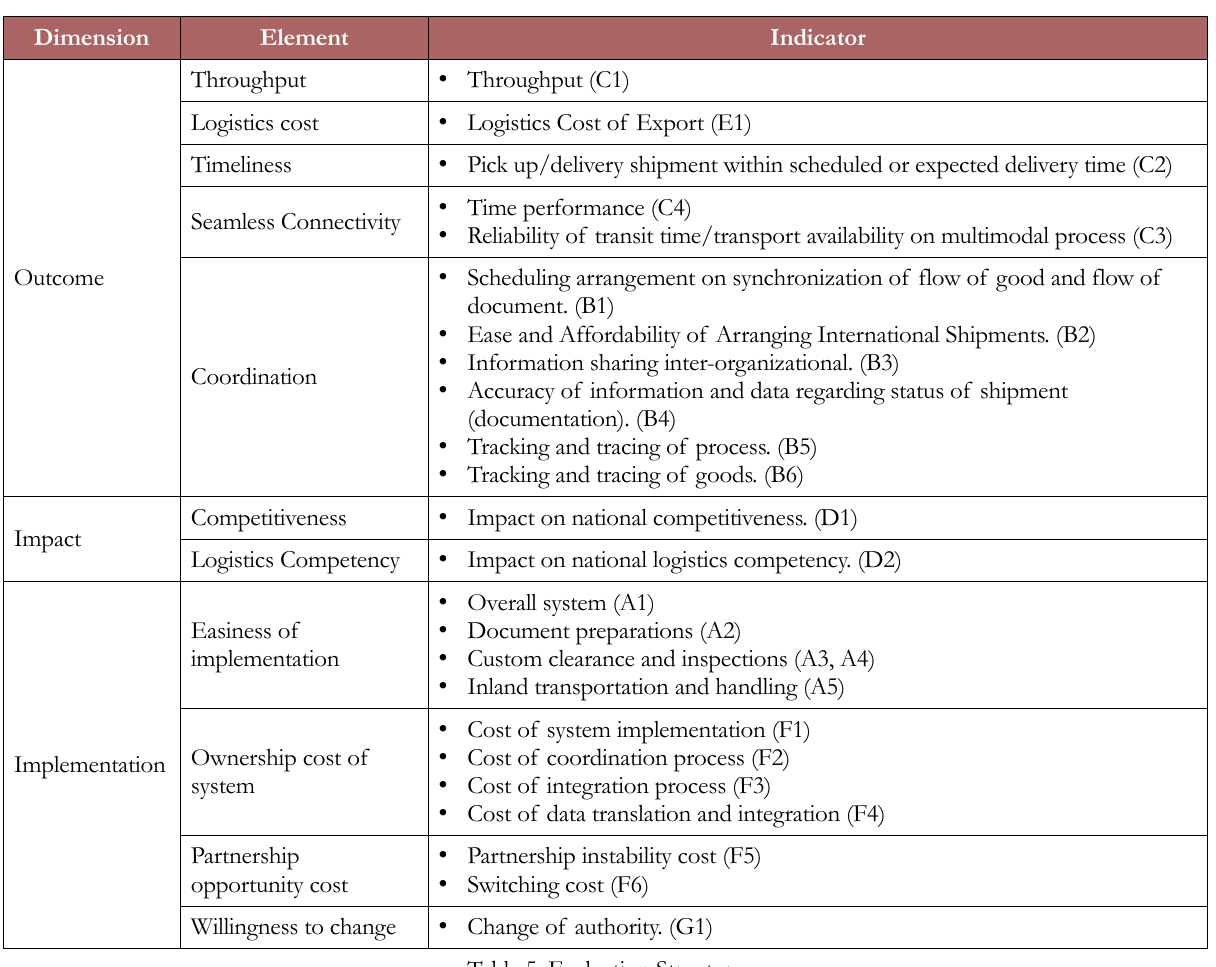
Table 5. Evaluation